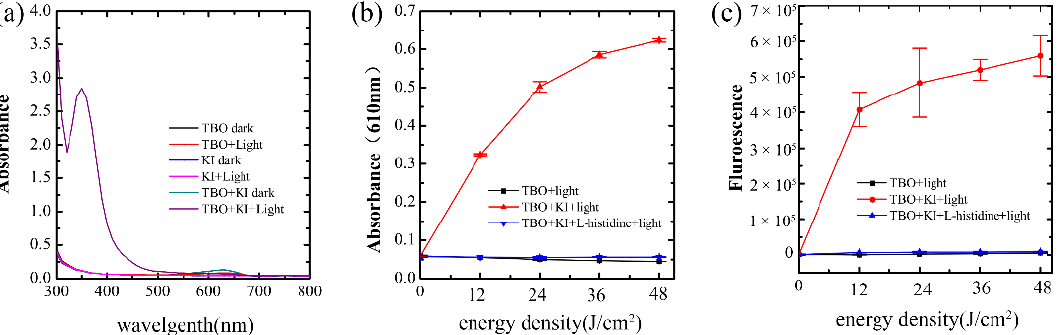
Figure 5. ( a ) The spectrum of different reaction mixtures at dark and after illumination. ( b ) Production of iodine measured by starch indicator assay. ( c ) Production of hydrogen peroxide (H 2 O 2 ) measured by Amplex Red assay.